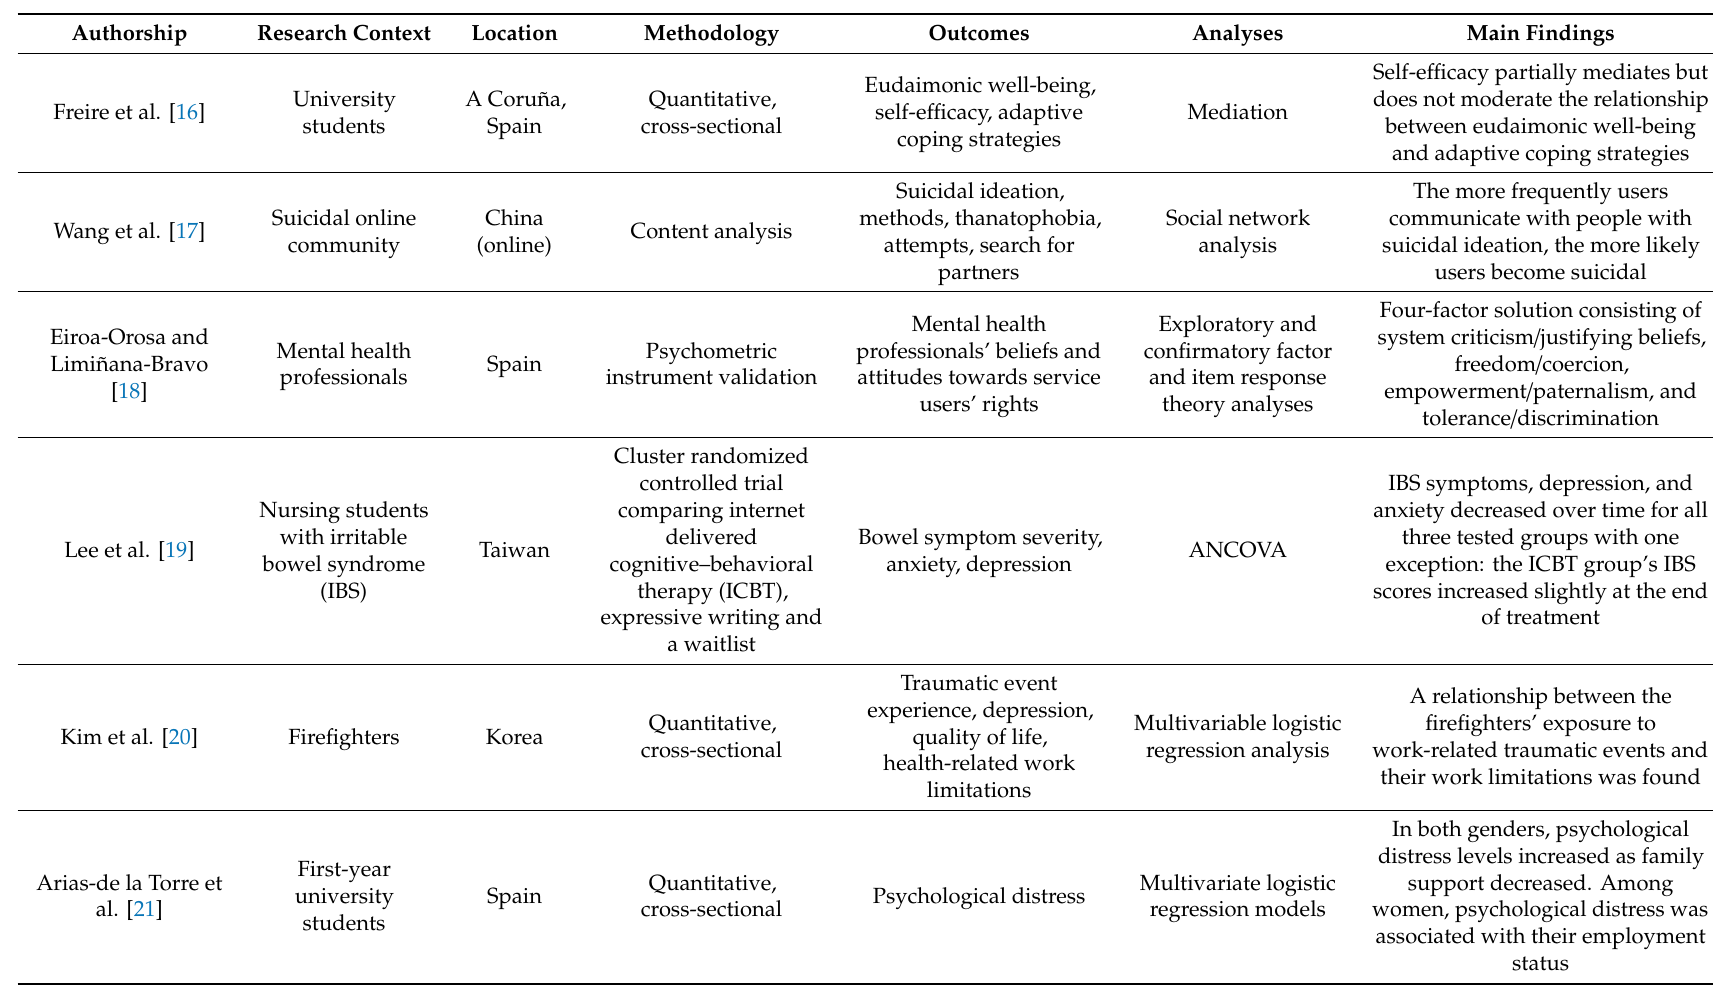
Table 1. Description of the articles included in the Special Issue in chronological publishing